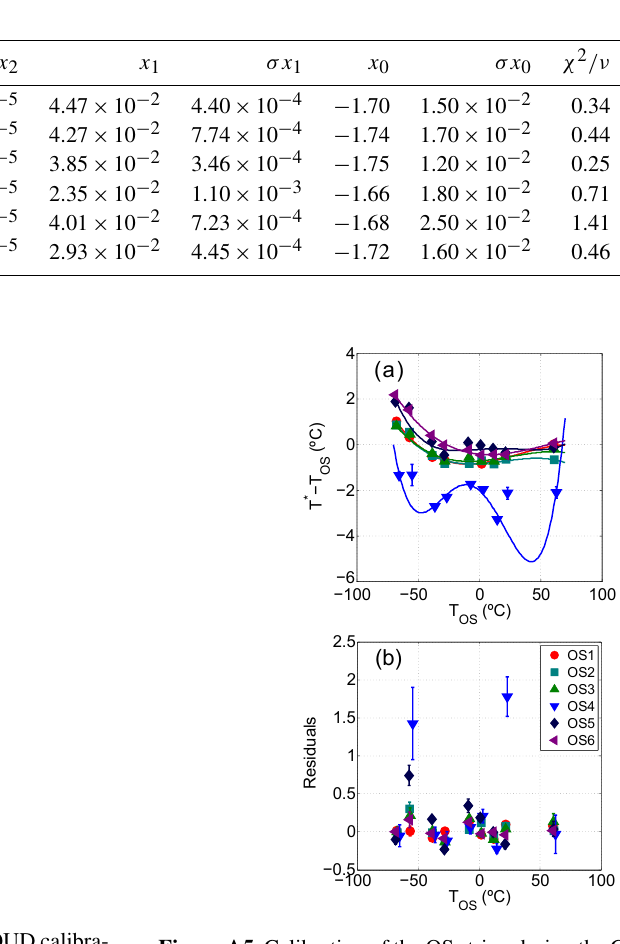
Figure A5. Calibration of the OS string during the CLOUD calibra- tion campaign: (a) fitted calibration curves (Eq. A2 with k s = 3 or 4) and (b) residuals from the calibration